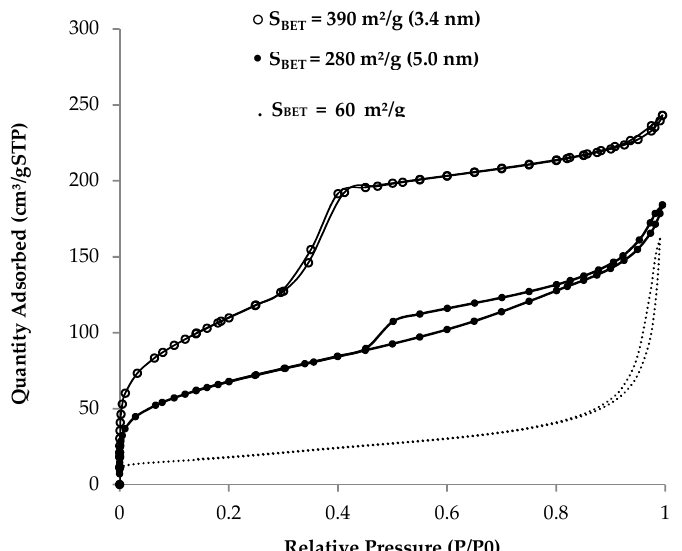
Figure 2. Nitrogen adsorption/desorption isotherms of ( ○ ) Ru/CB@SiO 2 (C) and (•) Ru/CB@SiO 2 (P) materials in comparison with the starting uncovered Ru/CB (dotted line) catalyst.